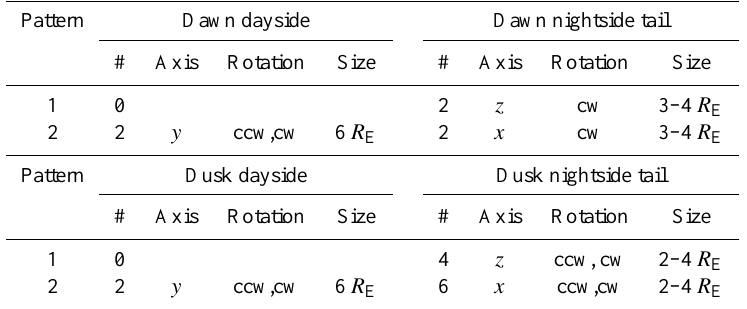
Fig. 6. Same as Fig. 2, but for the vortices found for case 2 (higher solar wind speed). The vortices rotating clockwise are represented in red color and those rotating counterclockwise are represented in blue. Table 2. Case 1: four quadrant vortex